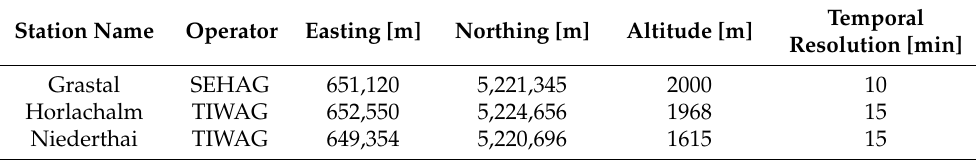
Table 3. Site parameters of the meteorological stations used within this study.